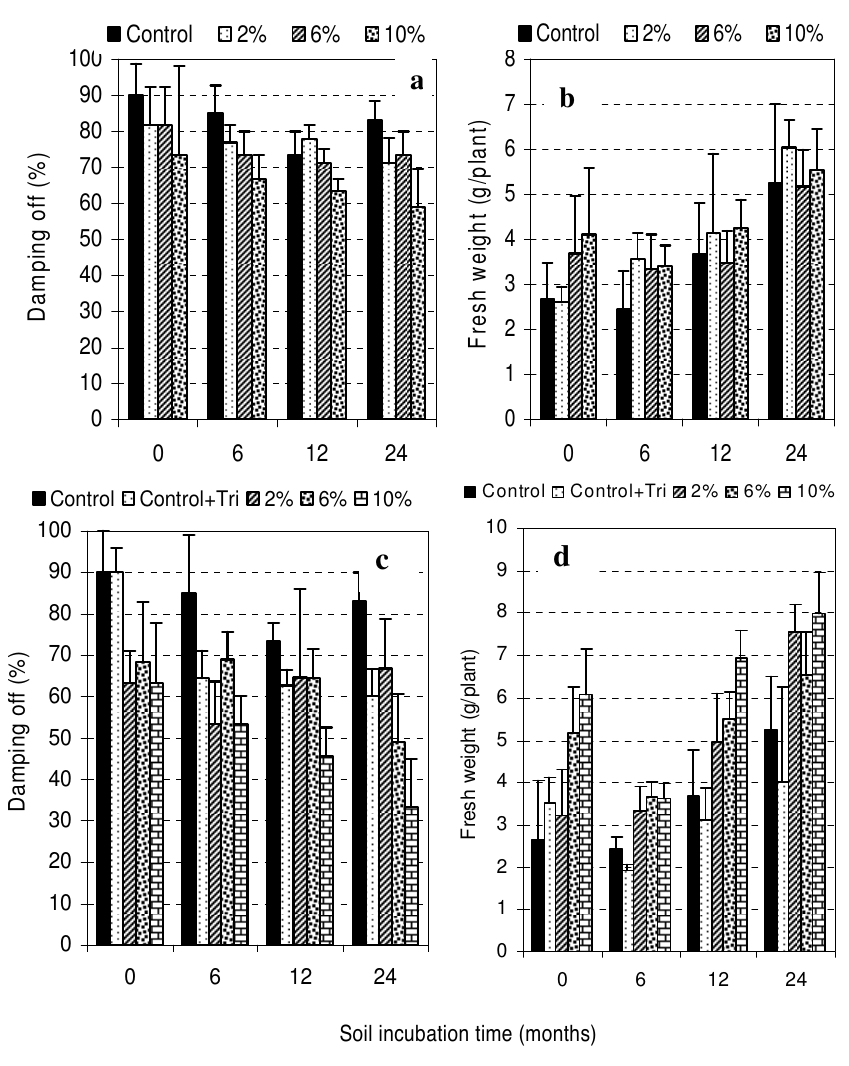
Fig. 1. Effect of incubation of manure amendment in soil on: a, bean damping off (%) caused by Rhizoctonia solani ; b, bean fresh weight (g plant -1 ). Effect of a combination of Trichoderma harzianum and organic amendment on: c, bean damping off (%), and d, bean fresh weight (g plant -1 ). Vertical bars represent the standard deviation of replicates from the